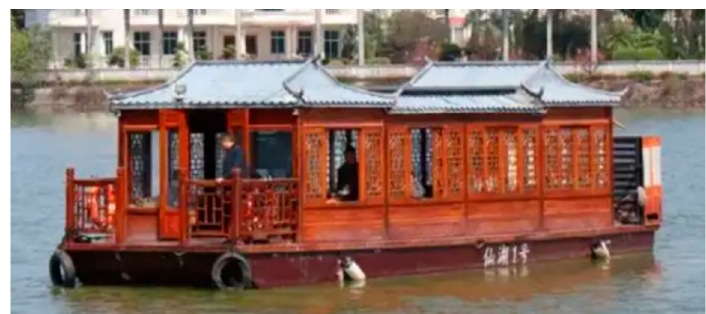
Figure 31. The cruise ship “Xian Hu 1” [155].